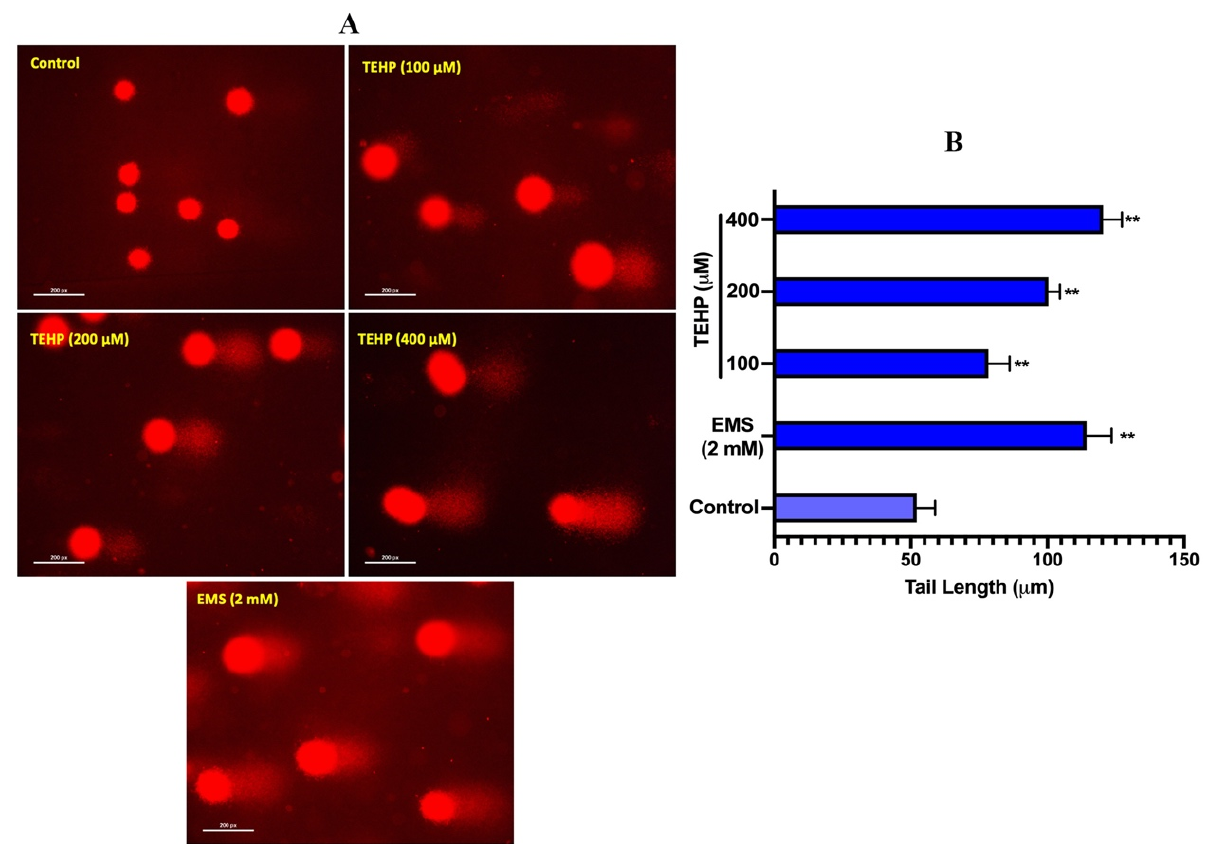
Figure 3. Alkaline comet assay depicting DNA damage in TEHP-treated HepG2 cells. ( A ) Typical comet assay images showing broken DNA liberated as tail from the nuclear head of HepG2 cells after 72 h of TEHP exposure. Ethyl methane sulfonate (EMS) was run as positive control. ( B ) Varying level of comet tail length measured after TEHP exposure. (** p < 0.01 versus control). Table 1. TEHP-induced DNA damage in HepG2 cells, analyzed using different parameters of alka- line comet assay.